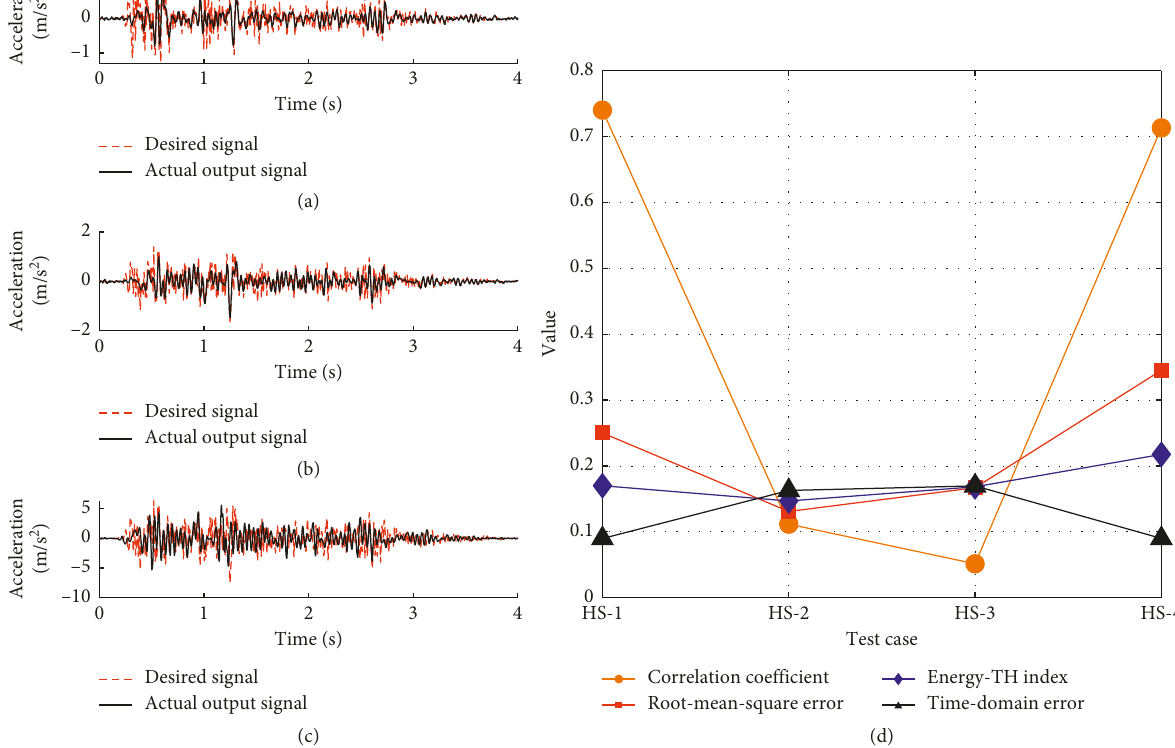
Figure 16: Shake table’s output and corresponding error of different test cases with high-speed railway station. (a) Case HS-1; (b) case HS-3; (c) case HS-4; (d) output error of test cases.